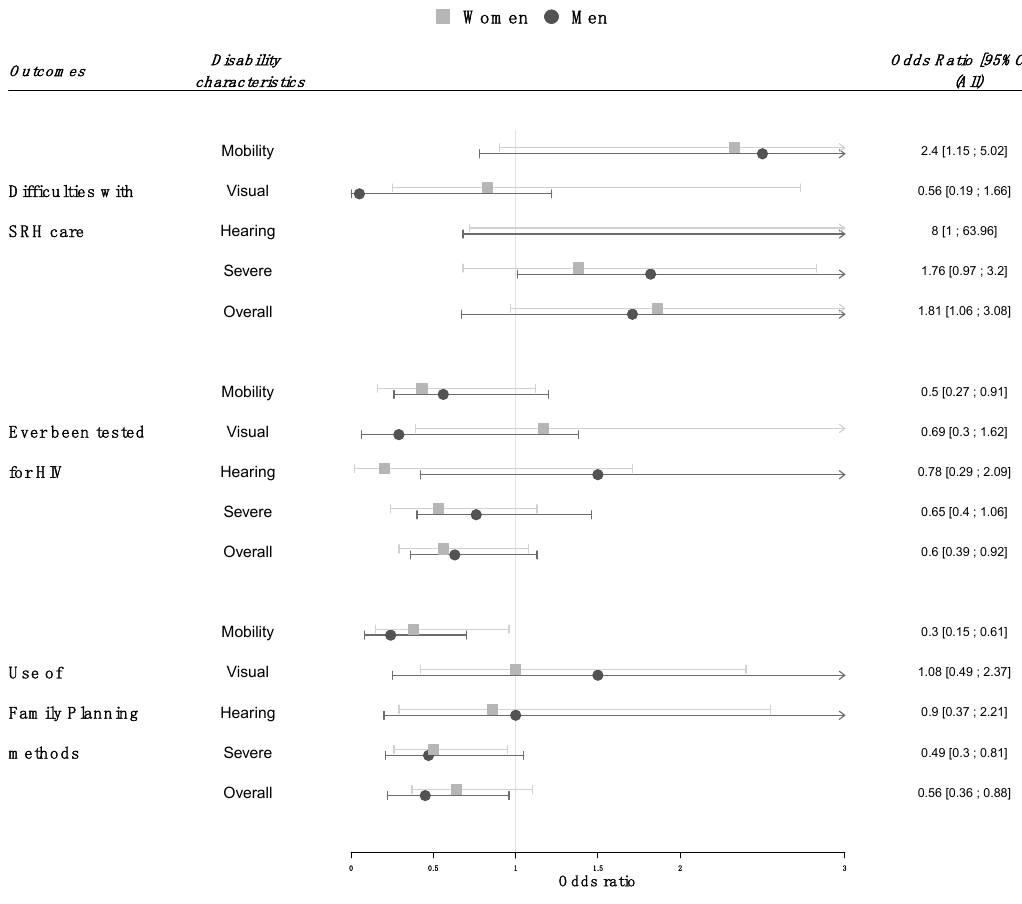
Figure 3. Frequencies among people with disabilities since childhood and odds ratio compared to people without disabilities of access to sexual and reproductive health services outcomes (overall, by sex and by type of activity limitations).